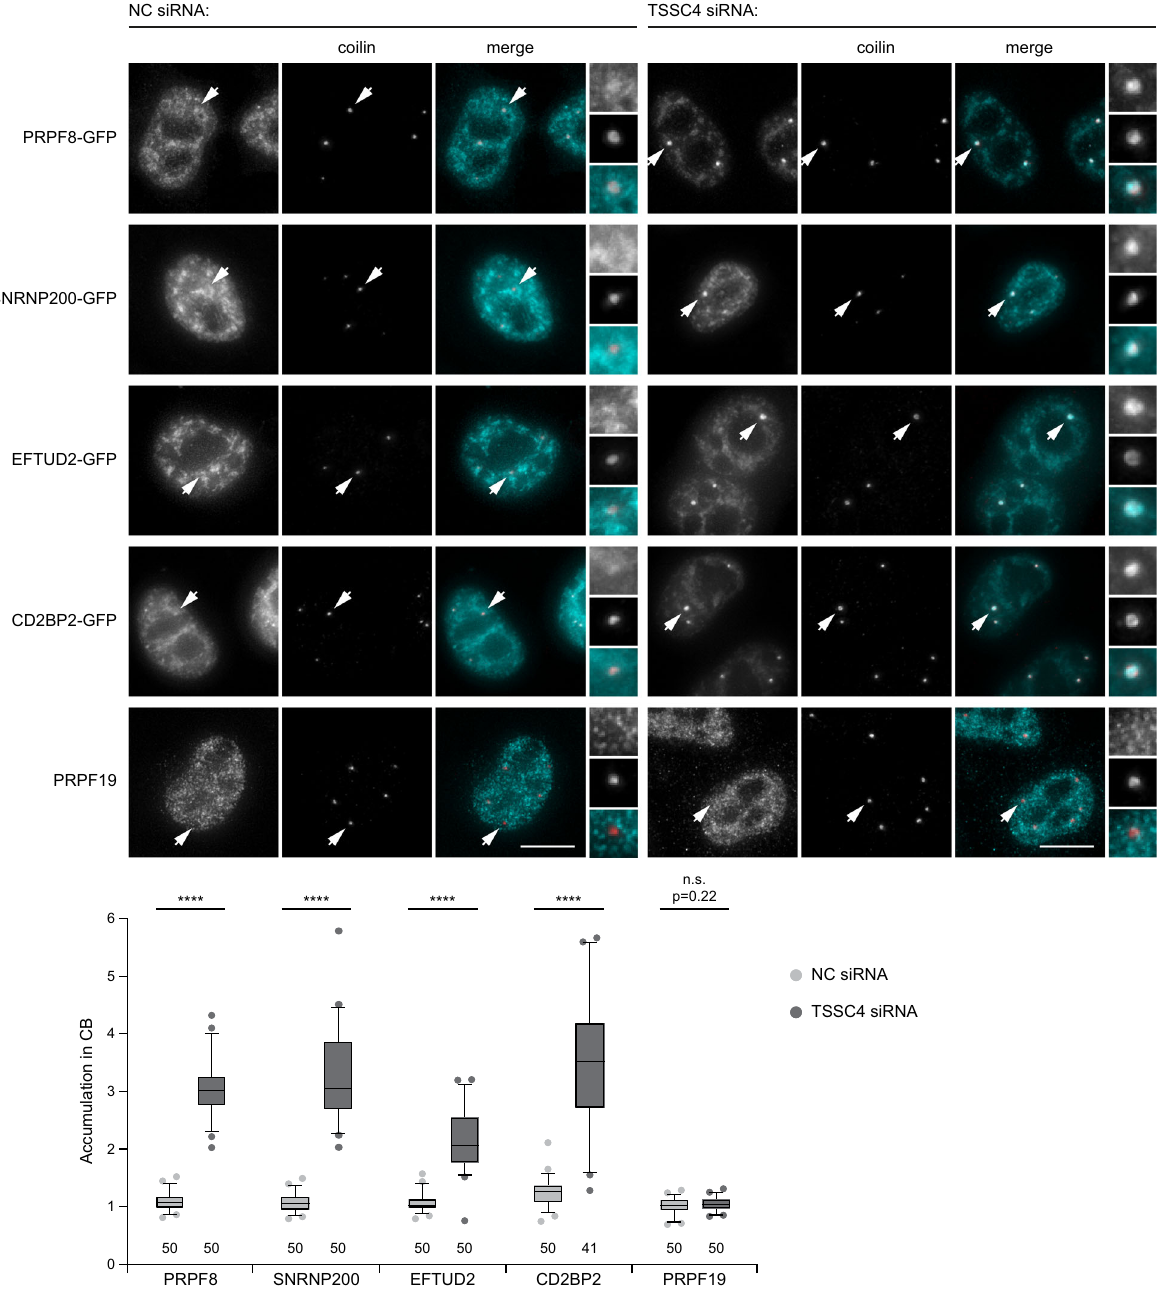
U5/PRPF19 particle. Interestingly, a single-nucleotide poly- morphism in the PRPF19 complex-interacting Hom4 region of TSSC4 has been associated with lower human height 37 , suggest- ing that this phenotype might be due to a defect in U5 snRNP recycling. Our co-puri fi cation assays suggest several modes of